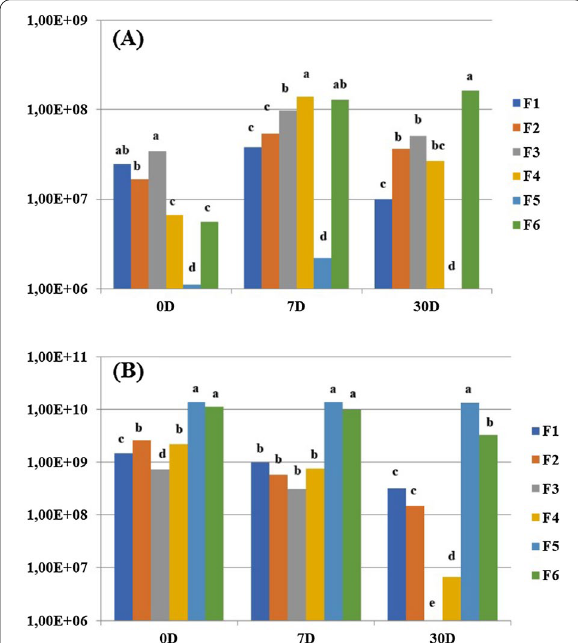
Fig. 1 Colony forming units (CFU mL-1) of six formulation (F1 to F6) of co-inoculant containing ( A ) Azospirillum and ( B ) Bradyrhizobium at the end of the co-cultivation period (zero day, 0D), and after seven (7D) and 30 (30D) days of storage. Means of three replicates and diferente letter denote statistical difference between treatments within each genus (Tukey, p < 5%)